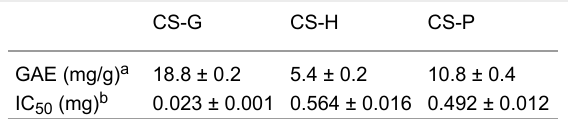
Table 2: Antioxidant properties of chitosans modified with phenolic compounds. CS-G